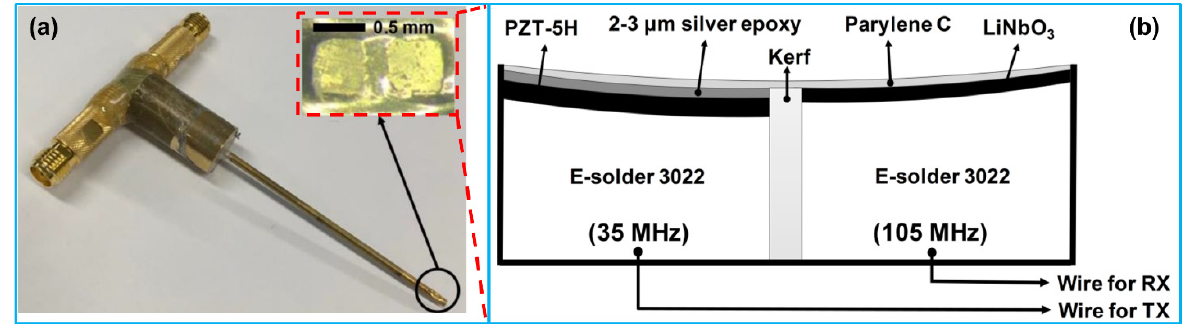
Figure 7. Dual frequency focused transducer for IVUS imaging using harmonics: ( a ) a photograph image of the fabricated transducer; ( b ) structure of the dual frequency focused transducer. Reprinted from [114] with permission.